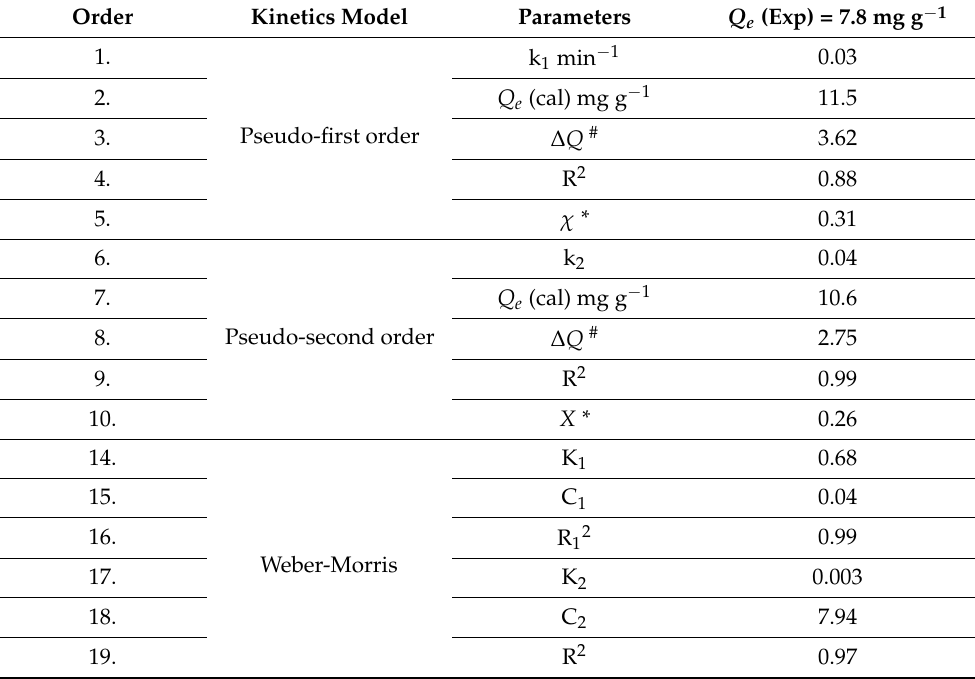
Table 5. Kinetic studies for CR adsorption onto Cu-ZnBO-Cp-CT